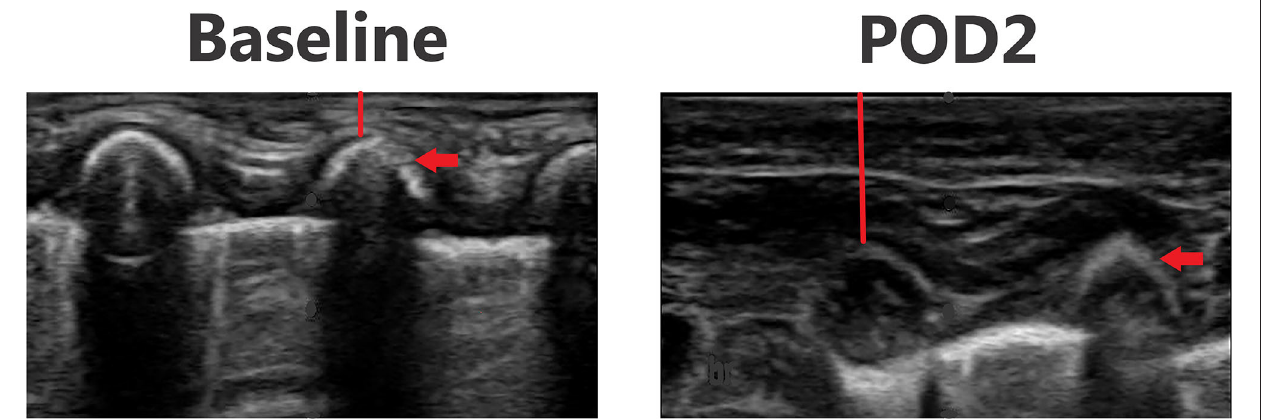
FIGURE 4 | Point-of-care ultrasound images of lateral chest at baseline and POD 2 of the same patient. Both images are presented on identical scales (total depth of 1.5cm from the skin). Red vertical line demonstrates subcutaneous tissue thickness—there is a marked increase in subcutaneous tissue seen on POD 2. Red arrow—rib bone.